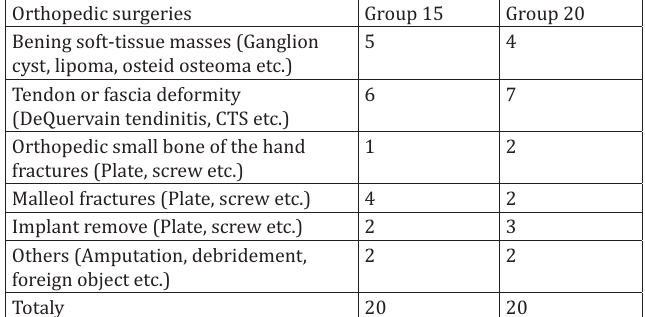
Distribution of the orthopedic surgeries Orthopedic surgeries Group 15 Group 20